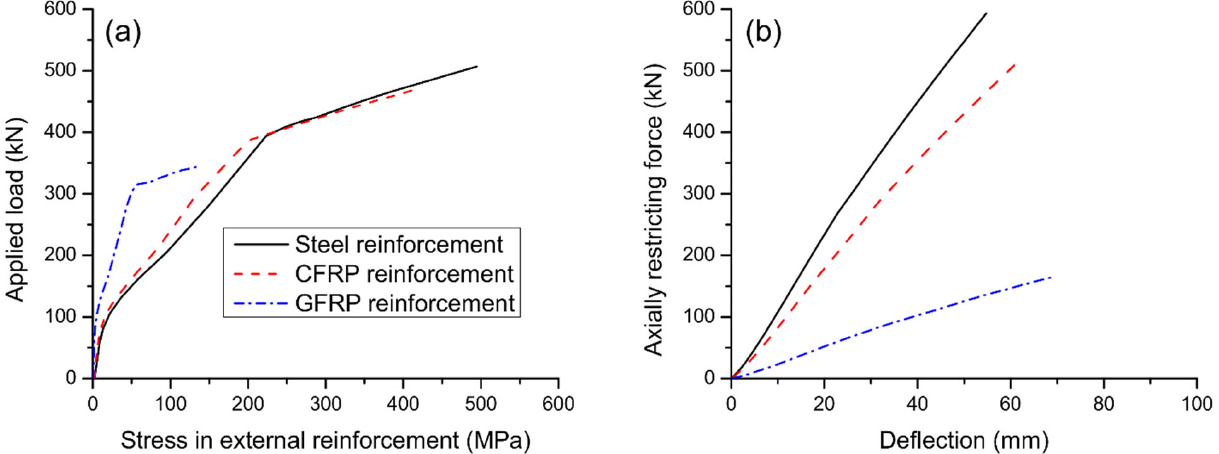
Figure 8. Effect of reinforcement type on the behavior of external reinforcement. ( a ) load versus reinforcement stress; ( b ) axially restricting force versus midspan deflection.